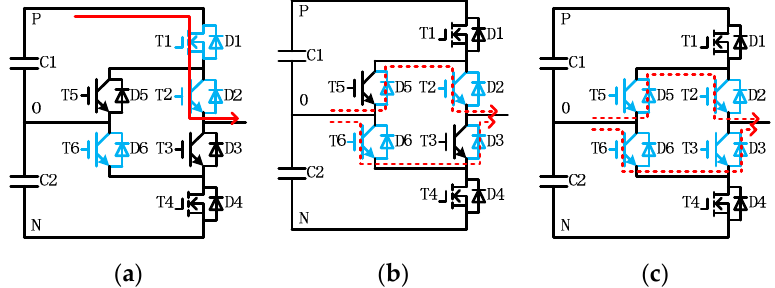
Figure 2. Commutation process between P and O: ( a ) P; ( b ) dead time; ( c ) O.